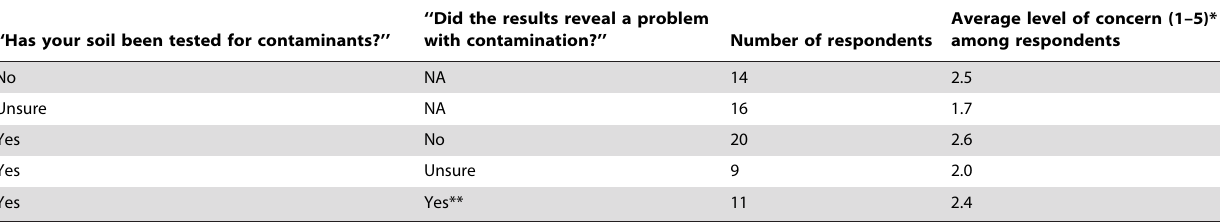
Table 3. Gardeners’ levels of concern about contaminants in their garden, by perceived soil test status.